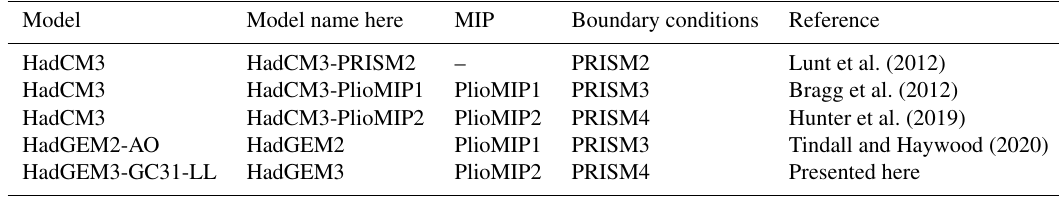
Table 2. Different generations of the UK physical climate model used here and their involvement with PlioMIP.